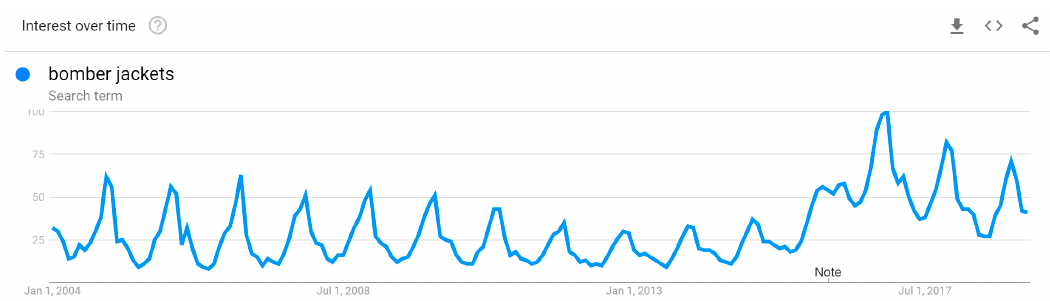
Figure 3. Google Trends for bomber jackets (January 2004–February 2019) (Data Source: Google Trends, 1 February 2019).